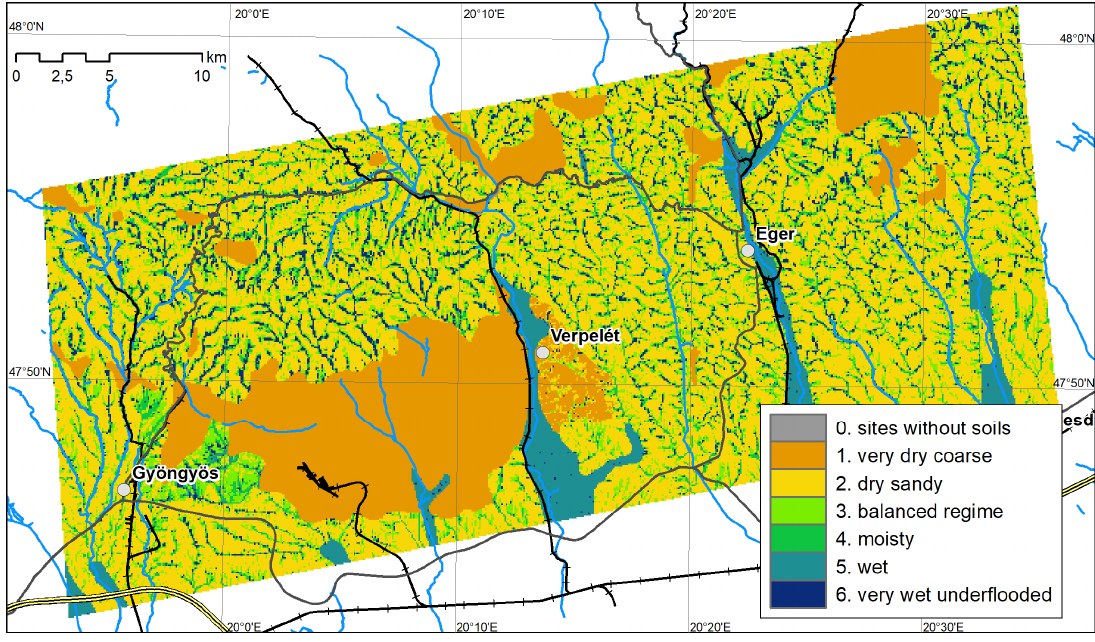
Figure 3. Morpho-pedotop moisture regime.